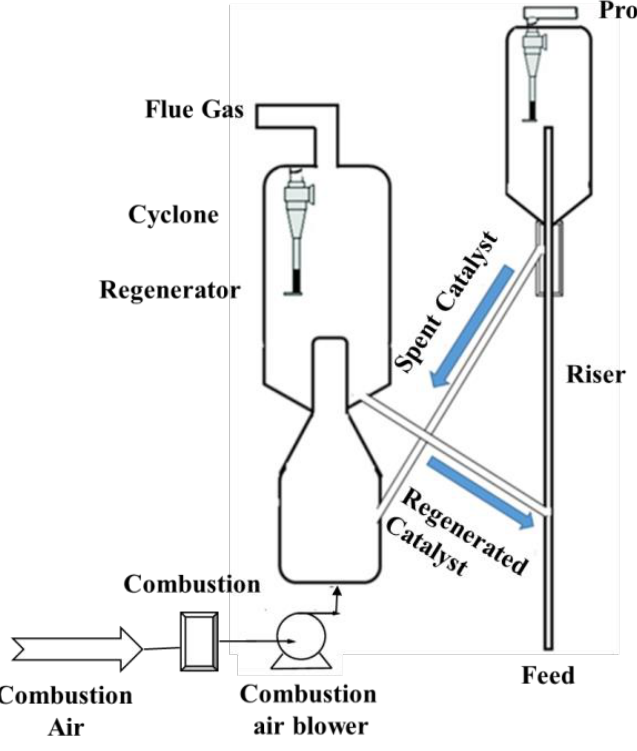
Figure 4. Fluidized-bed reactor unit.